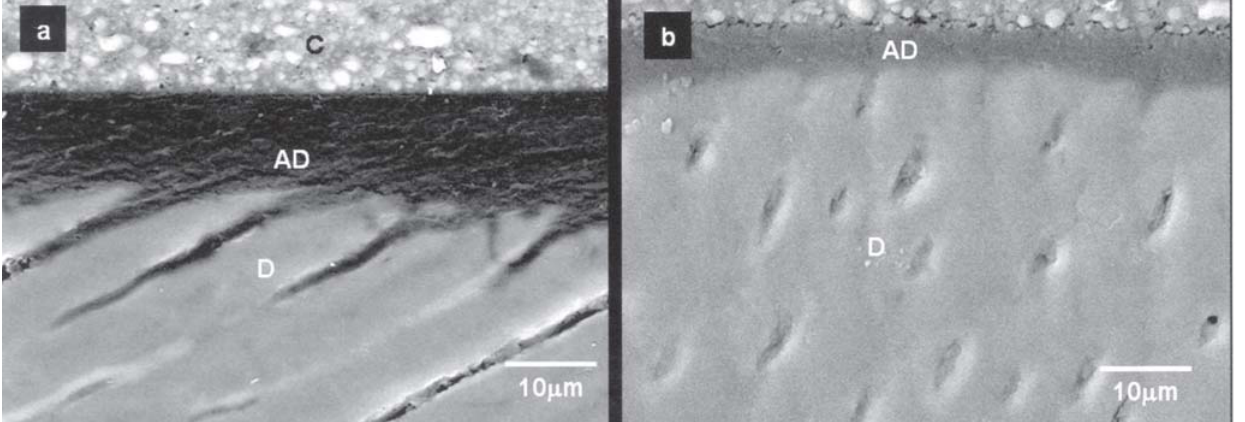
FIGURE 3- Backscattered SEM images of the resin-dentin interface bonded with SE (2500x). In (a), acid-etched specimen and in (b), acid-etched specimen treated with NaOCl. No silver deposition could be observed along the dentin-resin interface in both dentin treatments. (D) dentin; (C) composite resin; (AD) adhesive